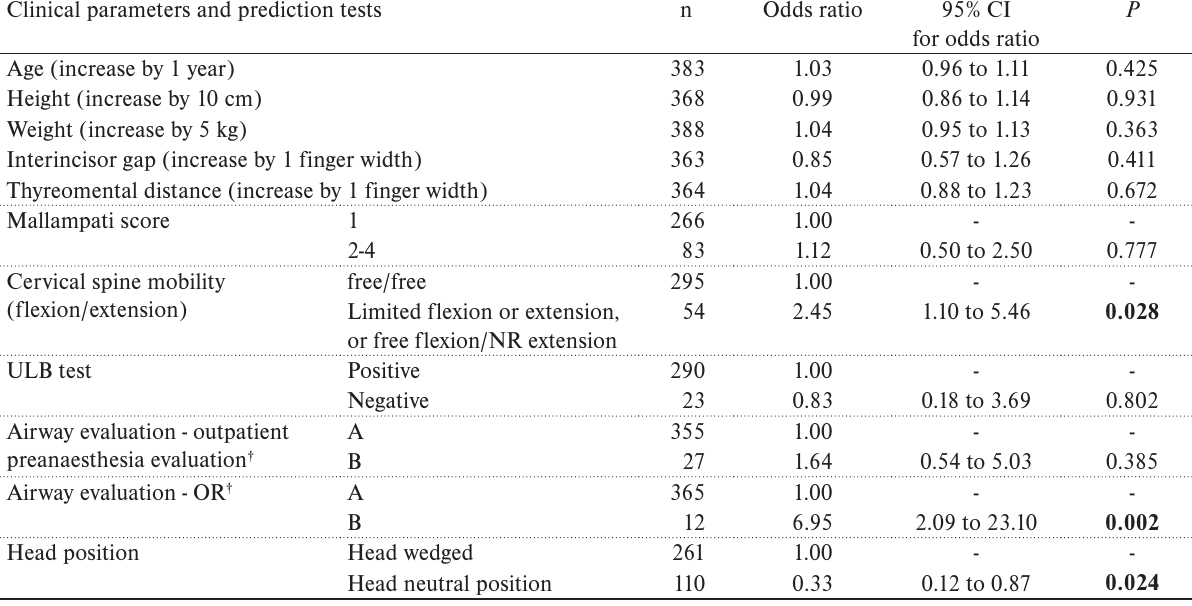
Table 5. Logistic regression analysis for EADA prediction and EADA